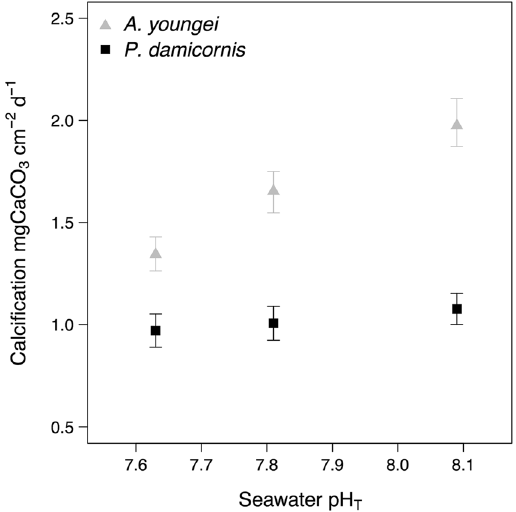
Figure 1. Effects of pCO 2 on the surface area-normalized net calcification of the corals Acropora youngei (grey triangles) and Pocillopora damicornis (black dots). Calcification was measured on corals that were incubated during 8 weeks under pH = 8.09, 7.81, and 7.63. Values displayed are mean ± SE (n = 12).